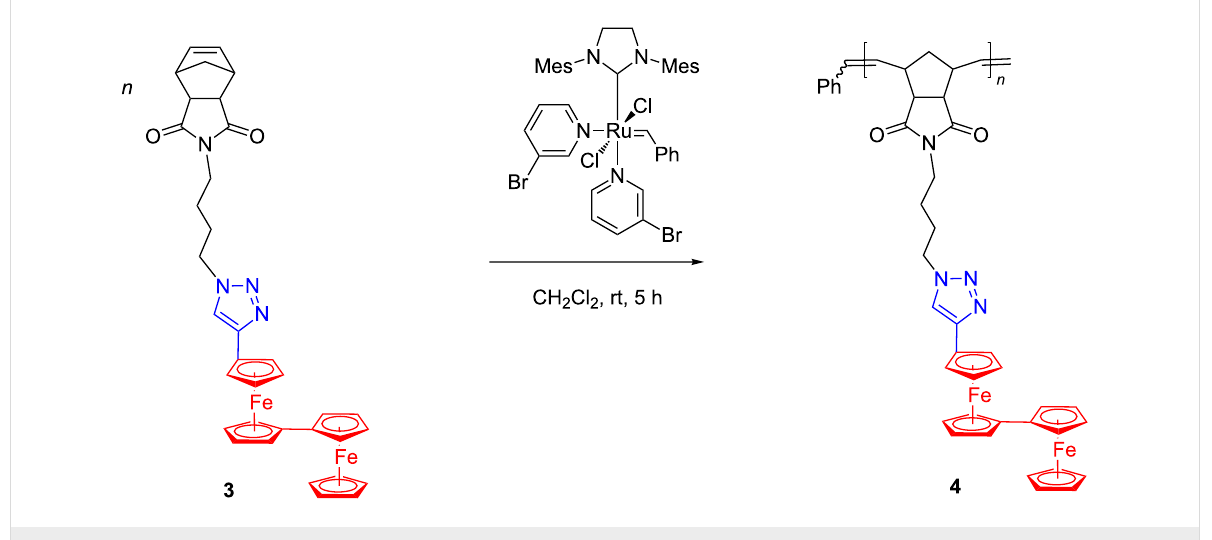
Scheme 2: Synthesis of redox-robust triazolylbiferrocenyl polymers 4